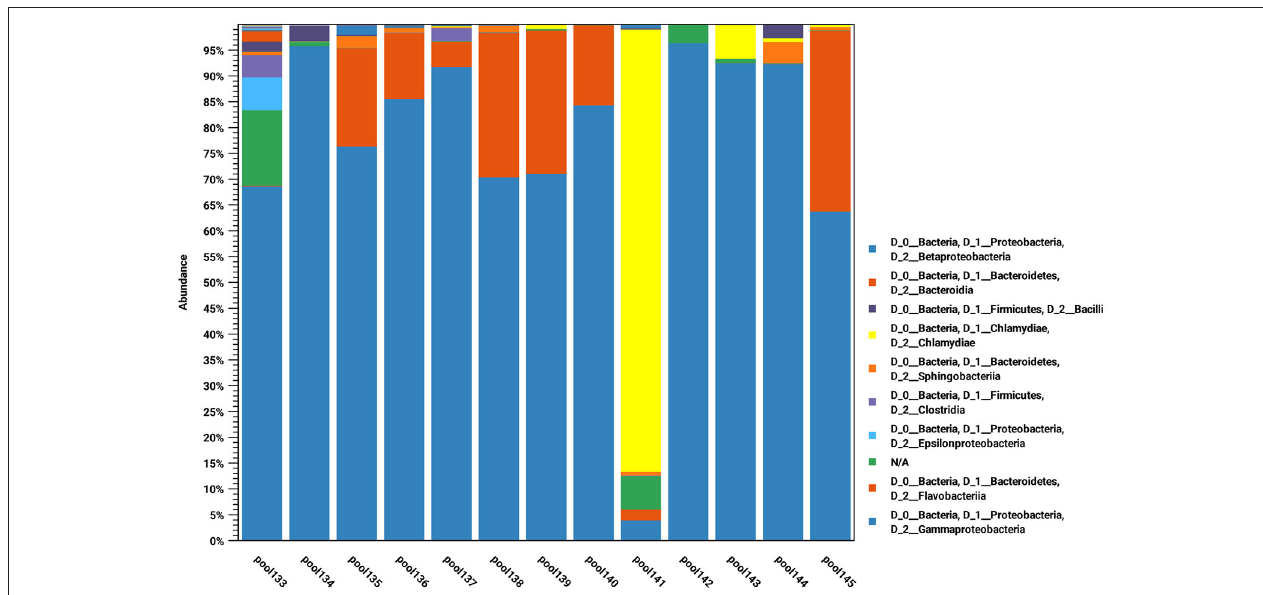
FIGURE 2 | The bacterial populations derived from 16S rRNA sequence classification for the indicated eye swab pools. The populations are displayed aggregated and colored at the taxonomic class and phylum levels, respectively.